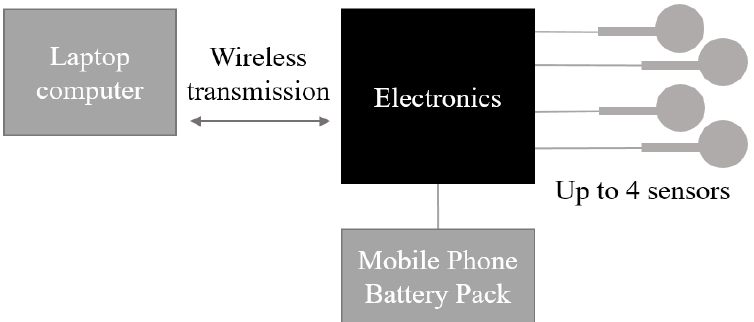
Figure 1. Schematic of an in-house wireless portable sensor system. The electronics module contains the Arduino Nano and transmitting Wixel and is powered by a standard USB power bank. The four sensors are connected via four I2C bus connectors.